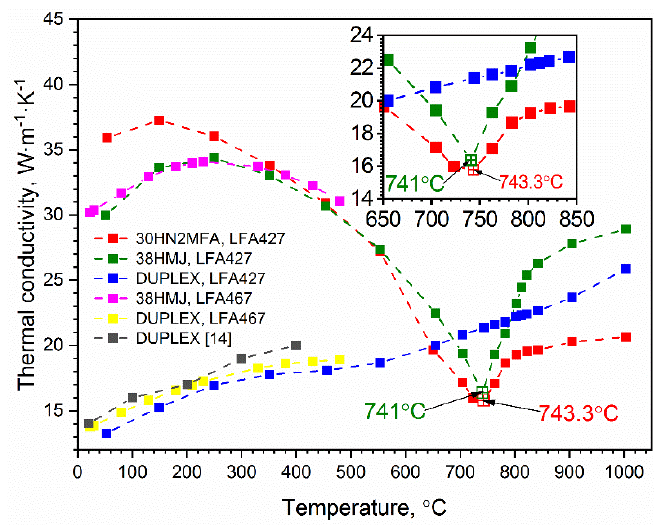
Figure 7. Thermal conductivity of three barrel steels (own calculations (Equation (2)) vs. literature data).